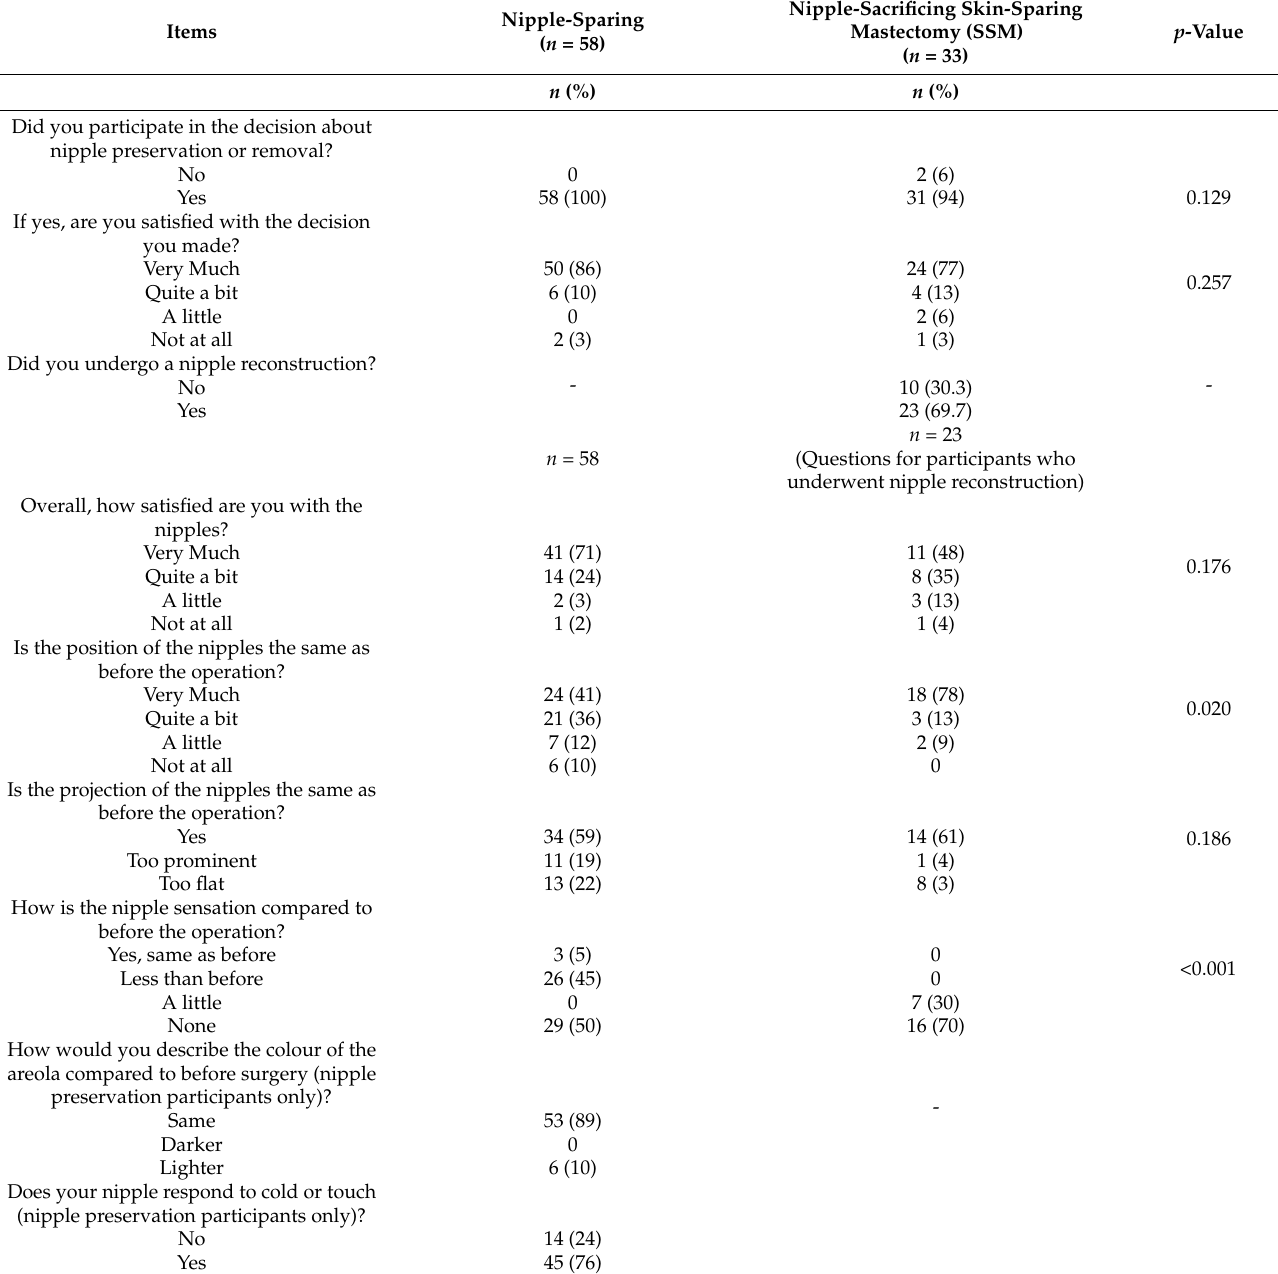
Table 4. Results of the patient questionnaire. There was no significant difference between the two groups except for nipple sensation and nipple